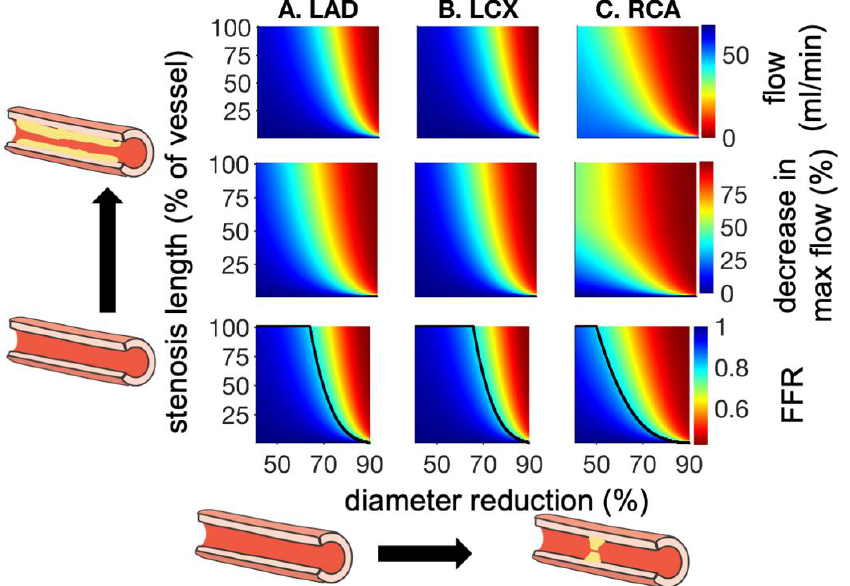
Figure 4. Dependence of flow rate (top row), maximum flow (middle row), and mean FFR (bottom row) on stenosis length (vertical axis, all panels) and vessel diameter (horizontal axis, all panels). Columns ( A – C ) show LAD, LCX, and RCA results, respectively. The black line in the bottom row demarcates the FFR = 0.8 threshold.